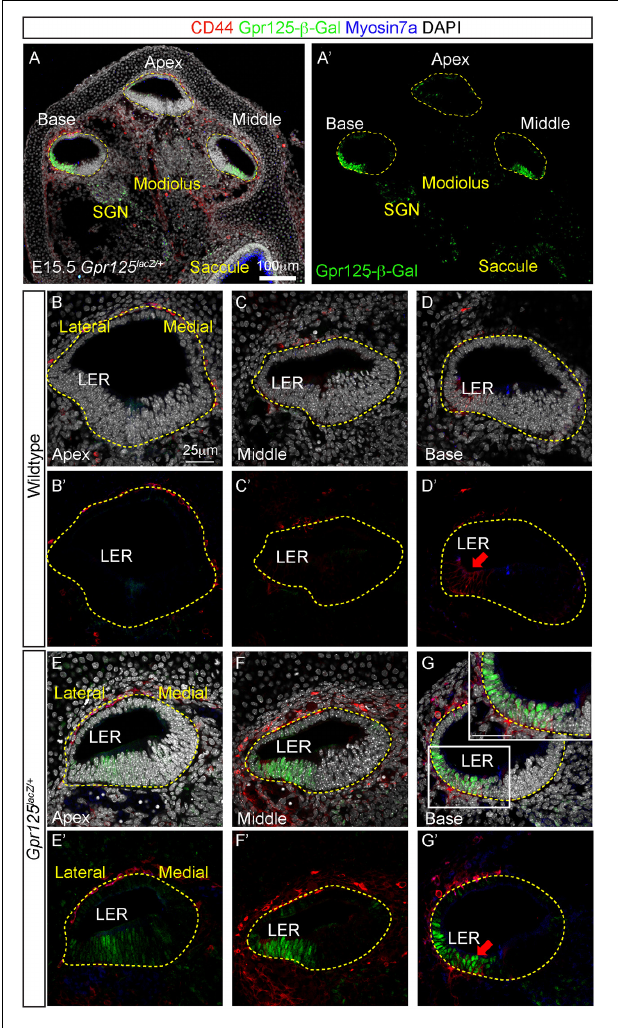
FIGURE 1 | Expression patterns of Gpr125 in E15.5 Gpr125 lacZ / + mice. (A,A’) Low-magnification images of midmodiolar cochlear sections of E15.5 Gpr125 lacZ / + mice. Co-immunostaining of Gpr125- β -Gal (green), CD44 (red), and Myosin 7a (blue) shown in each cochlear turn. Gpr125- β -Gal-positive cells primarily occupied the floor throughout the entire cochlear duct. (B–D’) No Gpr125- β -Gal-positive cells were found in the wild-type cochleae. (E–G’) In the Gpr125 lacZ / + cochleae, Gpr125- β -Gal expression was detected in the floor and SGNs of each cochlear turn. Expression is spatially restricted to the LER and outer sulcus, and more robust in the middle and base turn relative to the apex. Gpr125- β -Gal signal in the outer sulcus extends to the lower half of the lateral cochlear wall. Gpr125- β -Gal expression overlapped with CD44, which marks the LER only in the basal turn at this age. Inset in panel (G) shows high-magnification image. CD44 is also occasionally expressed in the periotic mesenchyme surrounding the cochlear duct. Red arrow marks CD44-positive cells in panels (D’,G’) . n = 4 for wild type, n = 3 for Gpr125 lacZ / + .